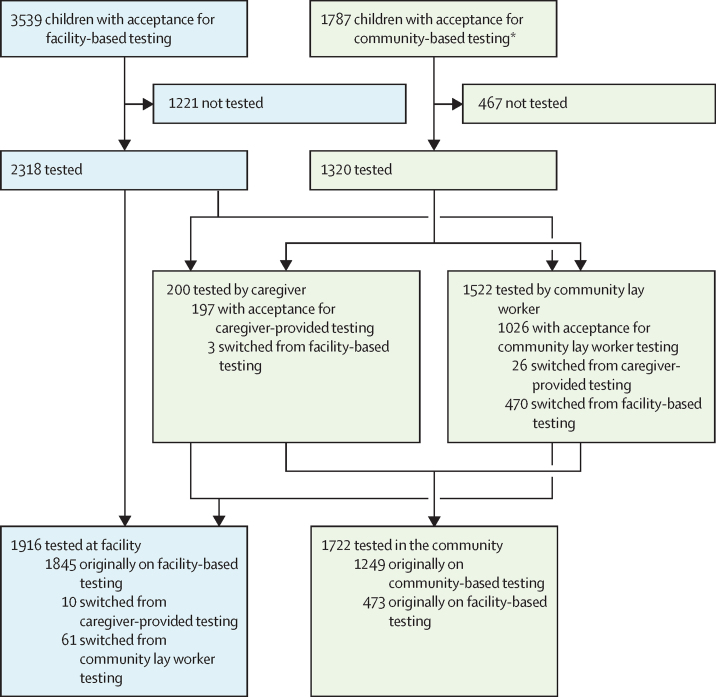
Selection of facility-based (blue) and community-based (green) HIV testing for eligible children whose index patient accepted testing*1487 children with acceptance for testing by a lay worker and 300 for testing by a caregiver at screening.